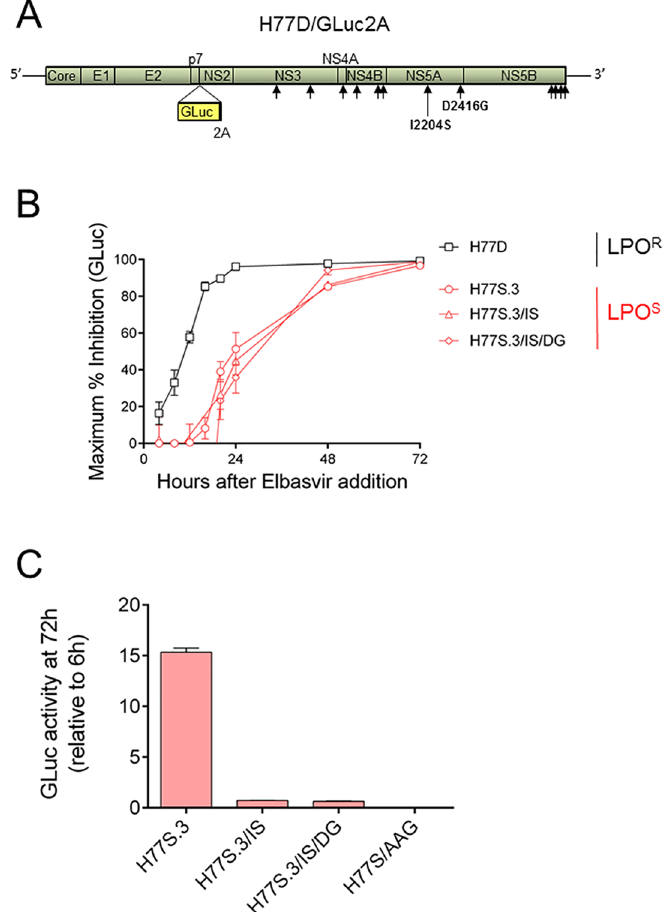
Fig 2. Differencesin kinetics of virus inhibition in H77S.3- vs H77D–infected cells following addition of an NS5A inhibitor are not due to differences in NS5A sequence. (A) Diagramof the H77S.3 genome showingpositionsof the 12 amino acids that differ betweenH77S.3 and H77D. The two amino acid changes in the NS5A coding region(I2204S and D2416G) are highlighted.(B) Maximum % inhibition(E max ) at different time points after addition of elbasvir to Huh7.5 cells infected with either H77S.3/GLuc2A, H77D/GLuc2Aor H77S.3/GLuc2A carryingeither the I2204S mutation alone (H77S.3/IS) or in combination with D2416G (H77S.3/IS/DG). (C) Fitness of different virus genomesused in (B) at 72 h post electroporation. Data shown represents GLuc activity relativeto GLuc activity at 6 h post electroporation to normalizefor